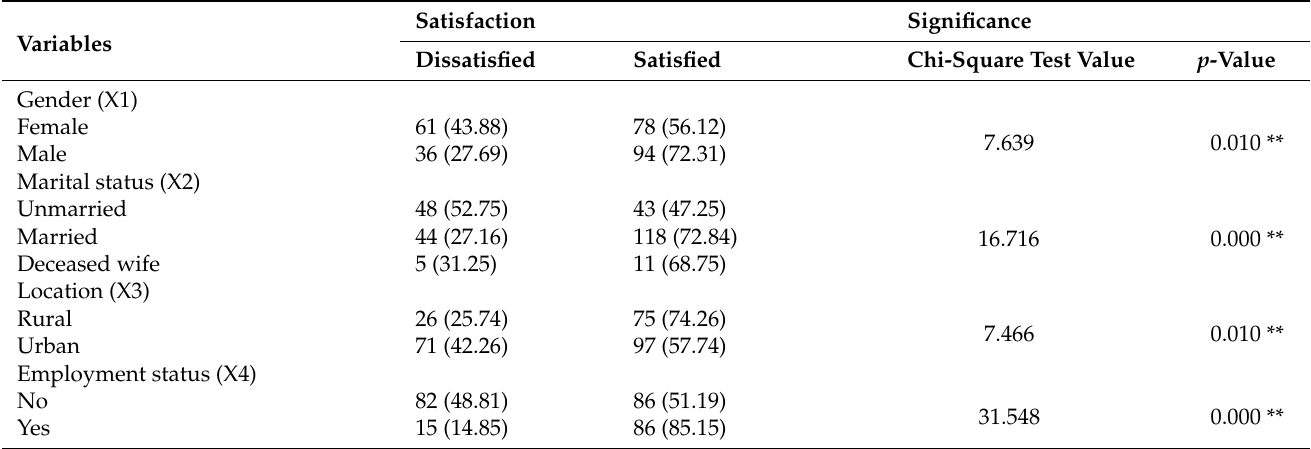
Table 2. Patient comparison by